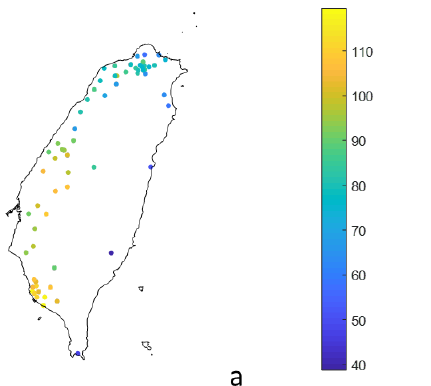
Figure 3. Average extreme PM 2.5 concentration within 96 h for 5-year ( a ) and 100-year ( b ) return periods (unit: μg/m 3 ).